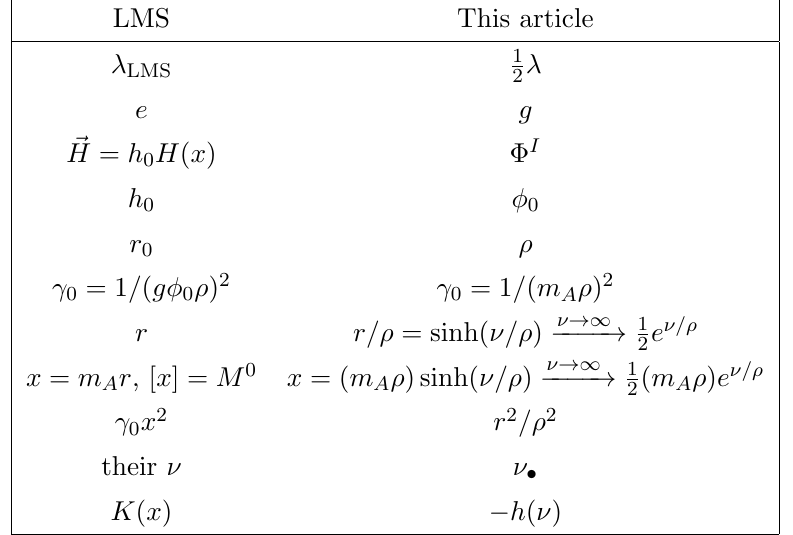
n 1 embedded in (cid:0) n 1 and a (cid:13)at M (cid:0) AdS n 1 and 2 (cid:0) 1 . The (cid:0) 1 represented by the blue (cid:0) n 1 would (cid:0) 1 into M (cid:0) 1 are in(cid:12)nite. (cid:0)